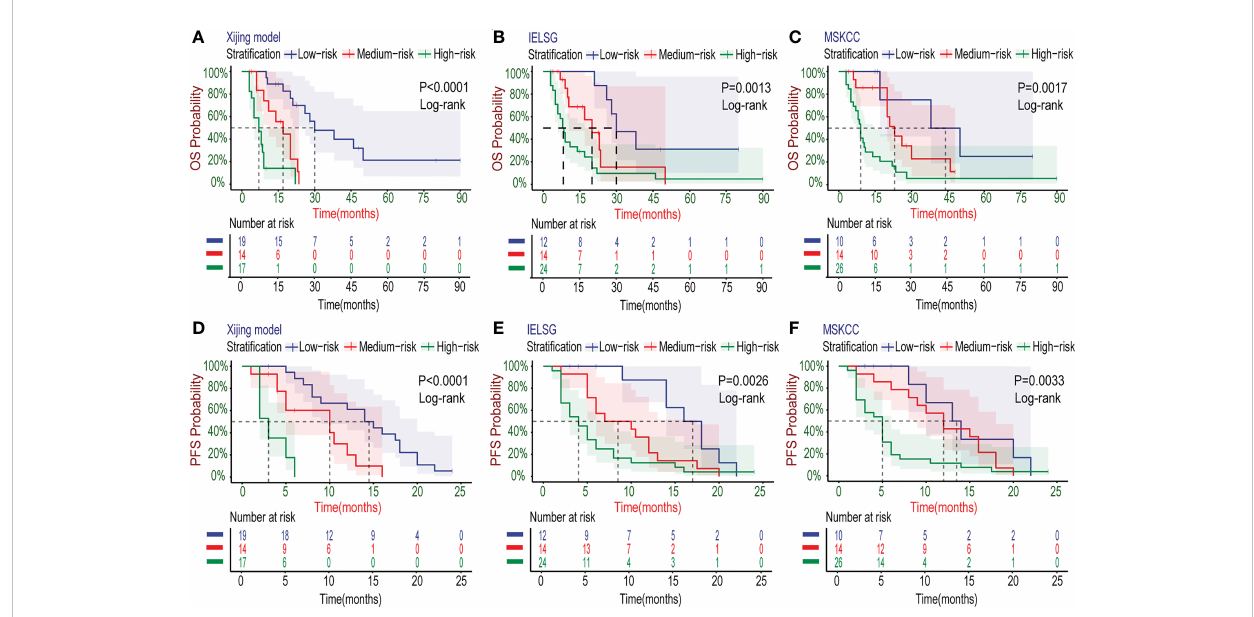
FIGURE 8 Kaplan – Meier survival curves in the validation cohort. (A-C) The OS curves of PCNSL patients strati fi ed by the Xijing Model, IELSG and MSKCC scores. (D-F) The PFS curves of PCNSL patients classi fi ed by the three risk strati fi